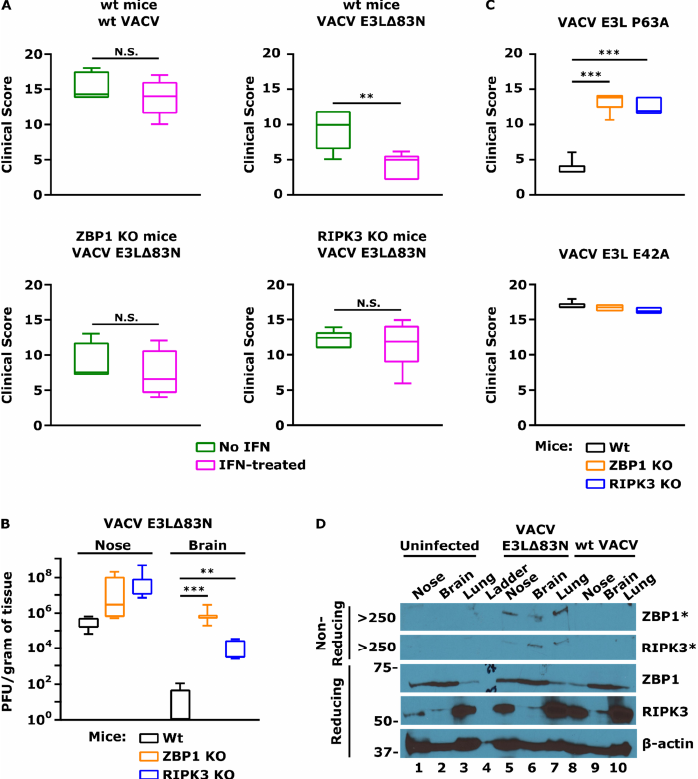
Figure 5. Significance of the ZBP1/RIPK3/MLKL axis for VACV pathogenesis. ( A ) Rescue of IFN resistance of VACV E3L ∆ 83N in ZBP1 − / − and RIPK3 − / − mice. C57BL/6 (wild-type or the indicated knockout) mice were infected IN with 10 6 pfu of either wild-type VACV or VACV E3L ∆ 83N in the presence or absence of IFN. Animals were monitored for disease progression for 5 days. Clinical scores on day 5 are presented. The wt VACV is highly pathogenic and resistant to IFN treatment (top left). VACV E3L ∆ 83N displayed IFN sensitivity (top right). Knocking out the necroptosis pathway led to IFN resistance of VACV E3L ∆ 83N, as displayed by infection of ZBP1 − / − mice (bottom left) and RIPK3 − / − mice (bottom right). Student’s t -test p -values: ** p < 0.01; N.S. p > 0.05 (no statistical difference). ( B ) Rescue of VACV E3L ∆ 83N spread in ZBP1 − / − and RIPK3 − / − mice. C57BL/6 (wild- type or the indicated knockout) mice were infected IN with 10 8 pfu of VACV E3L ∆ 83N and the indicated tissues were harvested on day 5 post-infection. The plaque assay revealed that VACV E3L ∆ 83N did not spread efficiently to the brain following IN inoculation of wt mice. Viral spread was rescued in mice with knockout of the necroptosis pathway: ZBP1 − / − and RIPK3 − / − mice. Student’s t -test p -values: ** p < 0.01; *** p < 0.001. ( C ) Rescue of VACV E3L P63A pathogenesis in ZBP1 − / − and RIPK3 − / − mice. C57BL/6 (wild-type or the indicated knockout) mice were infected IN with 10 6 pfu of either Z-NA-binding mutant VACV E3L P63A or control point mutant, VACV E3L E42A. Animals were monitored for disease progression like in A. VACV E3L P63A displayed decreased pathogenicity in wt mice (top) as opposed to the control mutant with unaffected ability to bind to Z-NA (bottom). VACV E3L P63A pathogenesis was restored in ZBP1 − / − and RIPK3 − / − mice, confirming results seen for VACV E3L ∆ 83N. Student’s t -test p -value: *** p < 0.001 ( D ) Activation of necroptosis in mice by VACV E3L ∆ 83N. C57BL/6 mice were infected IN with 10 8 pfu of VACV E3L ∆ 83N and the indicated tissues were harvested on day 5 post-infection. DSP crosslinking was performed as previously described [101]. Infection of mice with VACV E3L ∆ 83N resulted in the activation of ZBP1 and RIPK3 and necrosome formation (indicative of necroptosis) in the collected tissues (non-reducing gel), to which the virus was shown to spread in B. Necroptosis was not activated in mice infected with wt VACV or uninfected mice. Protein size reference is expressed in kiloDaltons (kDa). * indicates an aggregated form of the protein, present in the stacking gel, above the largest band (250 kDa) of the protein